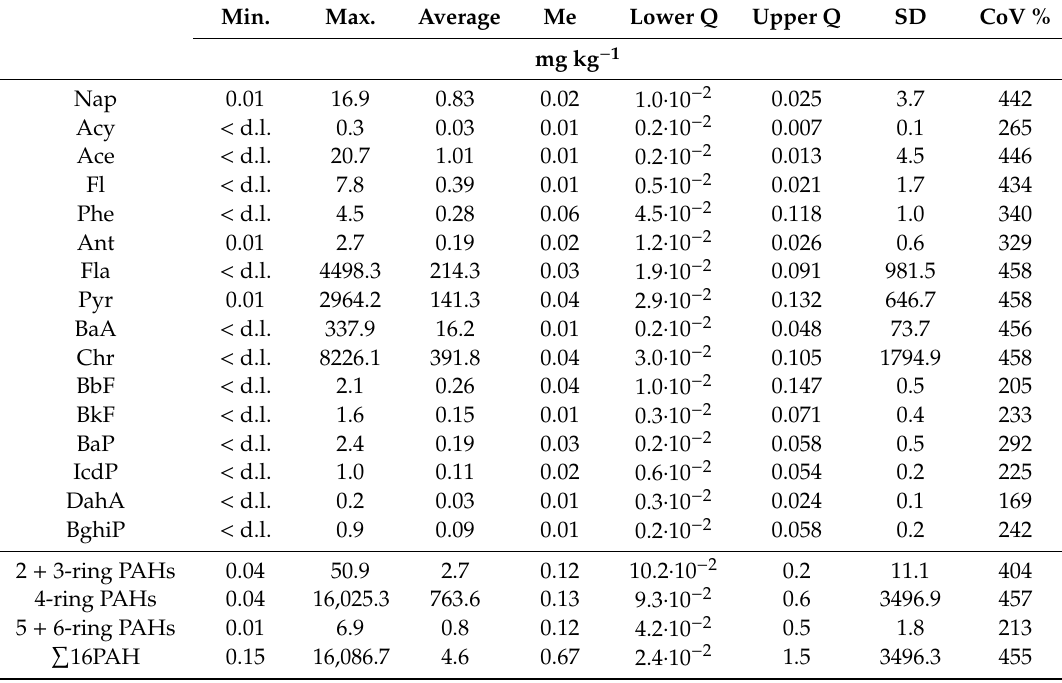
Table 3. Statistical evaluation of polycyclic aromatic hydrocarbons (PAHs) concentrations in soils (n = 21). Min.